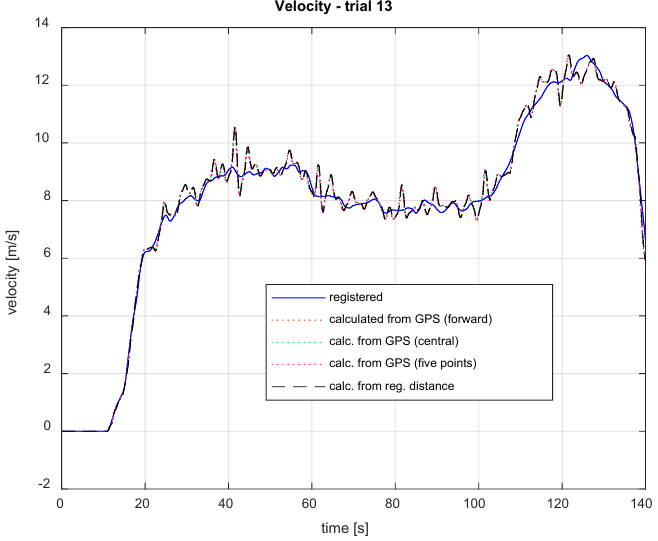
signals are characterized by significant oscillations in relation to the recorded signal.